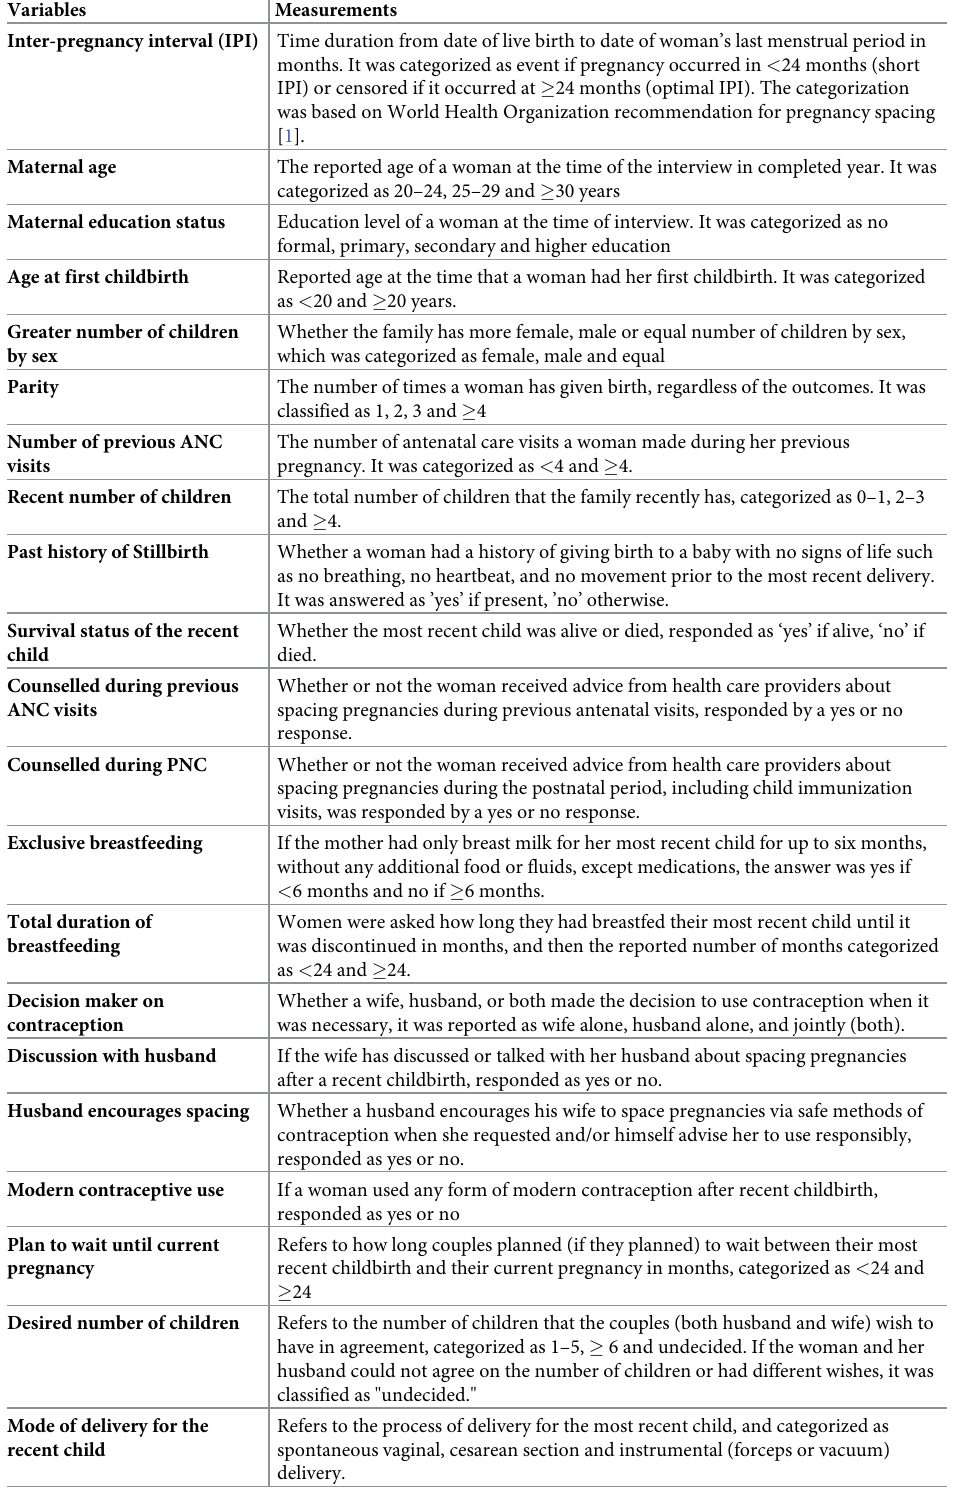
Table 1. List of variables, definitions and measurements for the study in urban South Ethiopia,